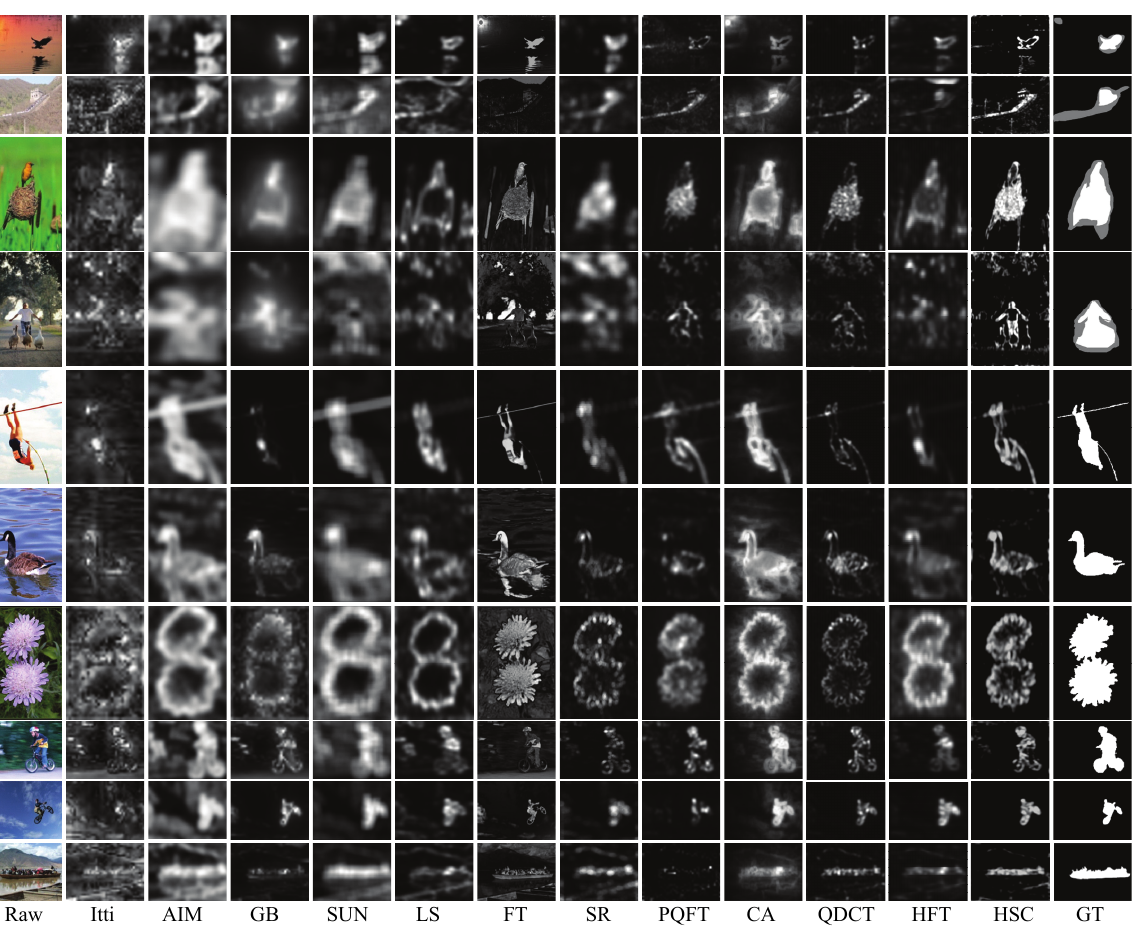
Figure 5. Comparison of our method with eleven state-of-the-art saliency methods. The first column is the raw images (Raw), the last column is the ground truth (GT), the second to twelfth column are results produced by Itti [13], attention information maximization (AIM) [14], graph-based visual saliency (GB) [15], saliency using natural statistics on Bayesian framework (SUN) [16], self-resemblance (LS) [18], FT [28],frequency-tuned ap- proach (FT) [26], PQFT [27], context-aware saliency (CA) [25], QDCT [39], hypercomplex Fourier transform (HFT) [34] and our proposed method (HSC),